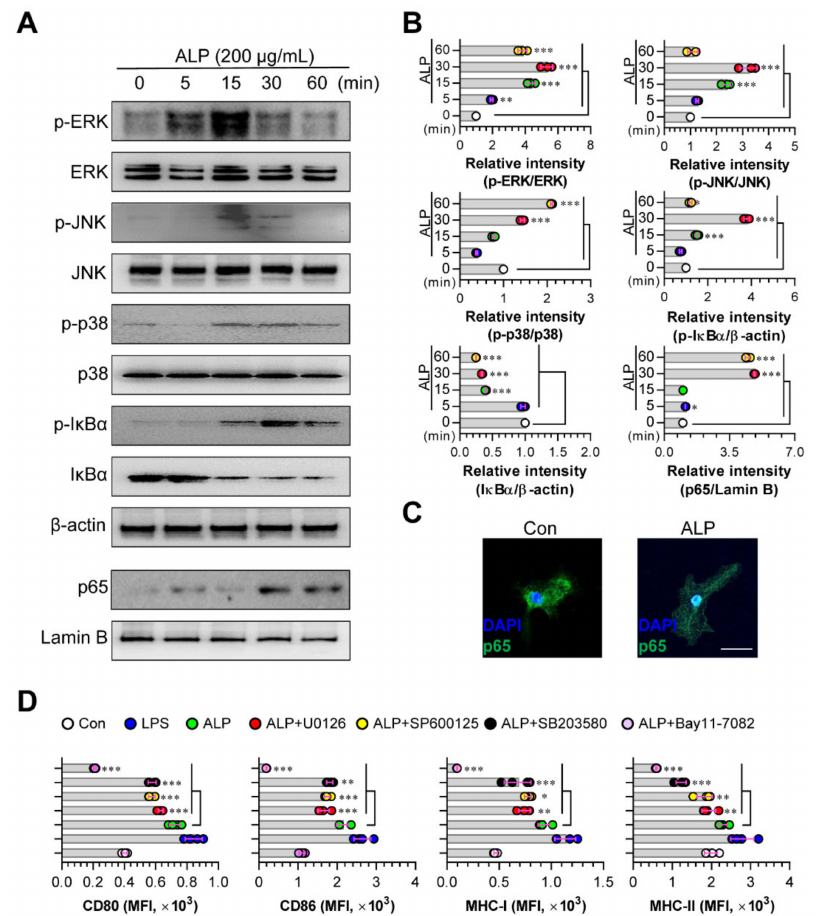
Figure 3. Activation of MAPK and NF- κ B signaling pathways in ALP-treated DCs. ( A ) Cells were stimulated with ALP (200 µ g / mL) for di ff erent times. After the incubation, the cells were lysed for protein extraction. SDS-PAGE and immunoblotting were performed to analyze the maturation signal using phosphorylated antigen-specific and total antigen-specific Abs against ERK, JNK, p38, and IkB- α . Data are representative of 3 independent experiments. ( B ) Western blotting data were analyzed using the Image J software to compare the phosphorylated and total forms. ( C ) The e ff ect of ALP on the nuclear translocation of p65 from the cytosol. Cells were stimulated with ALP (200 µ g / mL) for 1 h and stained with DAPI and Alexa 488-conjugated anti-NF- κ B (Scale bar: 10 µ m). ( D ) DCs pre-treated with the MAPK and NF- κ B signaling pathway inhibitors, U0126 (ERK), SP600125 (JNK), SB203580 (p38), and Bay11-7082 (NF- κ B) were incubated with ALP (200 µ g / mL) for 18 h. After incubation, the cells were assessed using FACS to detect the expression levels of CD80, CD86, MHC-I, and MHC-II. The results are indicated as mean ± SD ( n = 4 samples), representative of 3 experiments. * p < 0.05, ** p < 0.01, or *** p < 0.001. SD; standard